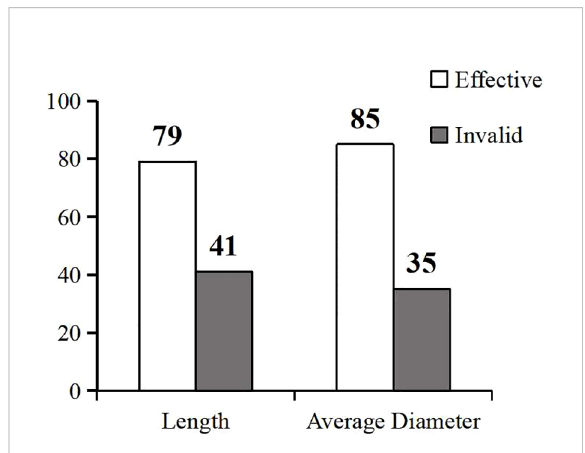
FIGURE 4 Validity analysis of exogenous melatonin in the common bean germplasm resources under salt stress. The gray columns represent the valid resources, while the white columns are the invalid